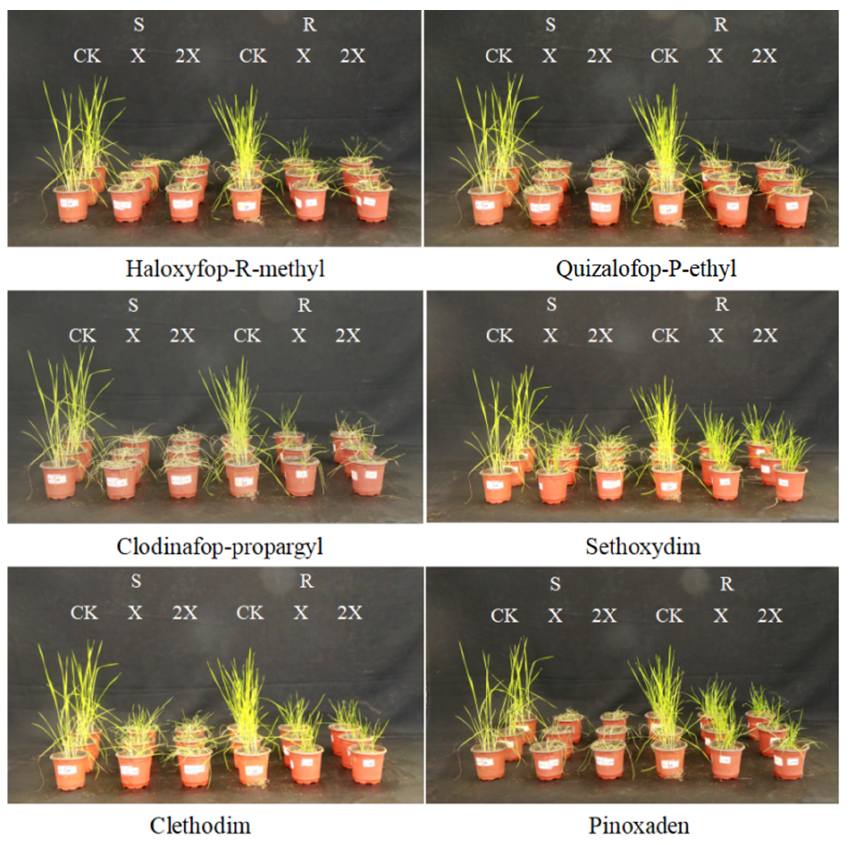
Figure 2. Growth response of resistant (R) and susceptible (S) Alopecurus japonicus populations to ACCase-inhibiting herbicides.